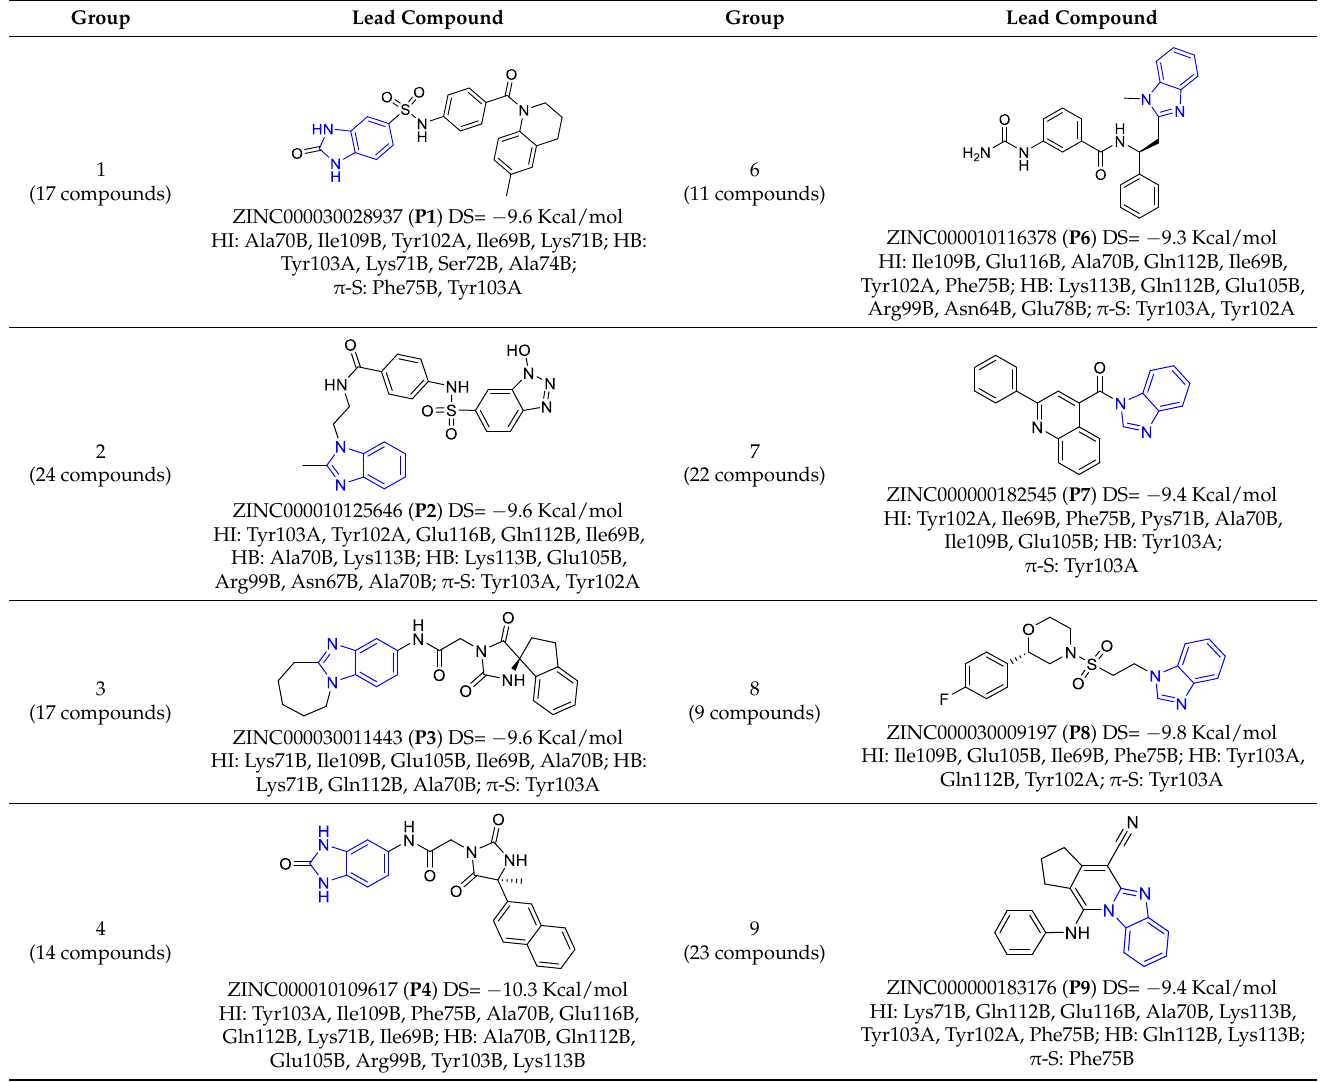
Table 2. Lead compounds from each group obtained by SBVS grouped by interaction profile. Lead Compound Group